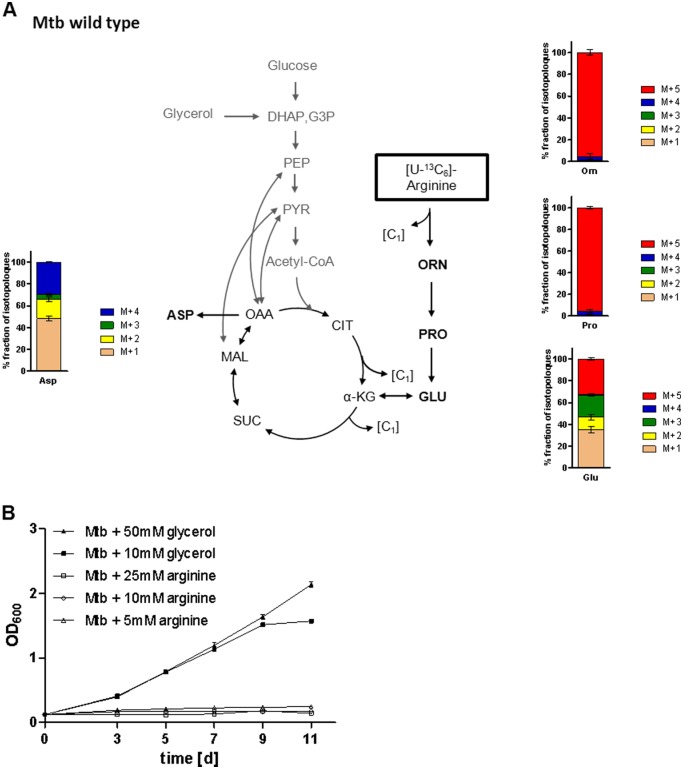
Relative isotopologue composition of amino acids derived from Mtb grown in presence of [U-13C6]arginine (A) and cultivation of Mtb on arginine as carbon source (B).
A) Mtb wild type was cultured for 7 days in minimal medium with glycerol and glucose as carbon sources and with 5 mM of a 1:1 mixture of [U-13C6]arginine) and unlabeled arginine as sole nitrogen source. 13C-Enrichments of ornithine, proline, glutamate, and aspartate were determined by GC-MS. Labeled ornithine and proline contained mainly M+5 isotopomers. Glutamate and aspartate showed more complex mixtures of multiple isotopomers. M+1, M+2, M+3, M+4, and M+5 indicate molecules with one to five 13C- labeled atoms, respectively (for 13C-excess of labeled amino acids see S2 Table). Mean values and standard deviations are shown for two independent biological experiments each measured in triplicate. B) Mtb wild type (Mtb) was cultured for 11 days in Sauton’s modified medium with 5 mM, 10 mM, or 25 mM of arginine (open symbols), or with 10 mM or 50 mM of glycerol (closed symbols) as single carbon source. Mean values and standard deviations are shown for three independent biological experiments.